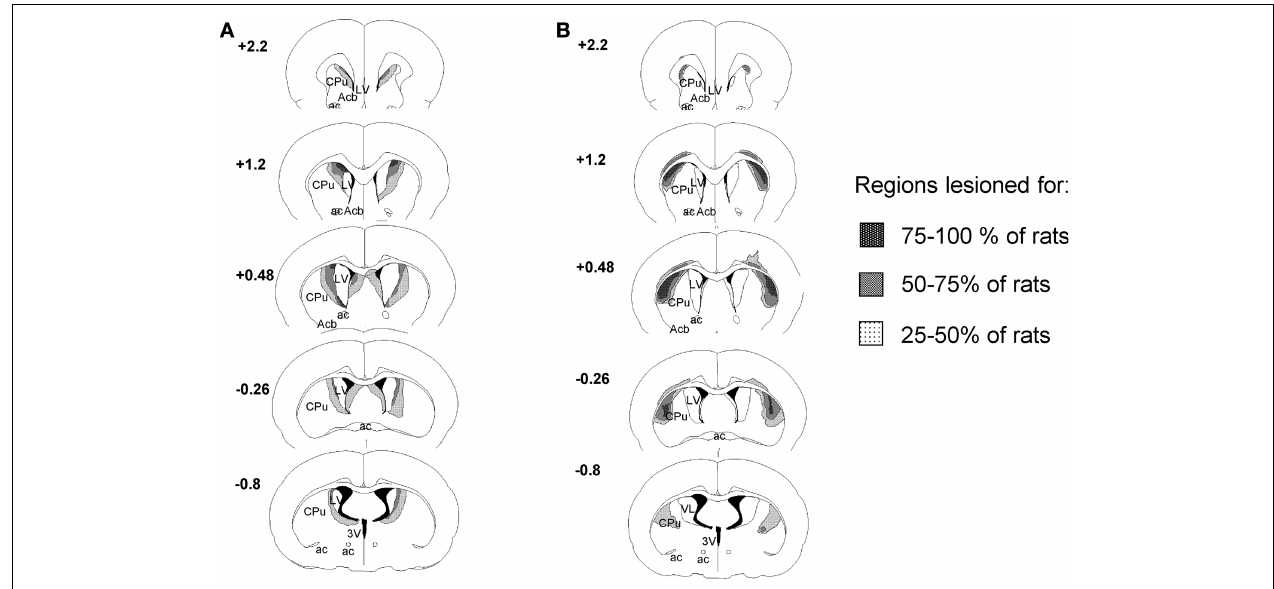
adapted from Krettek and Price (1977), Ac, anterior commissure; Acb, accumbens nucleus; CPu, caudate putamen; lDS, dorsolateral